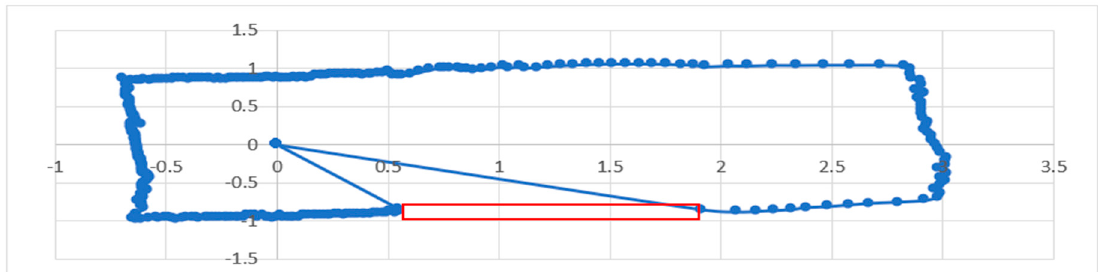
Figure 16. 360 laser scan points for range mapping radially around the robot. The red box shows the side mirror location.